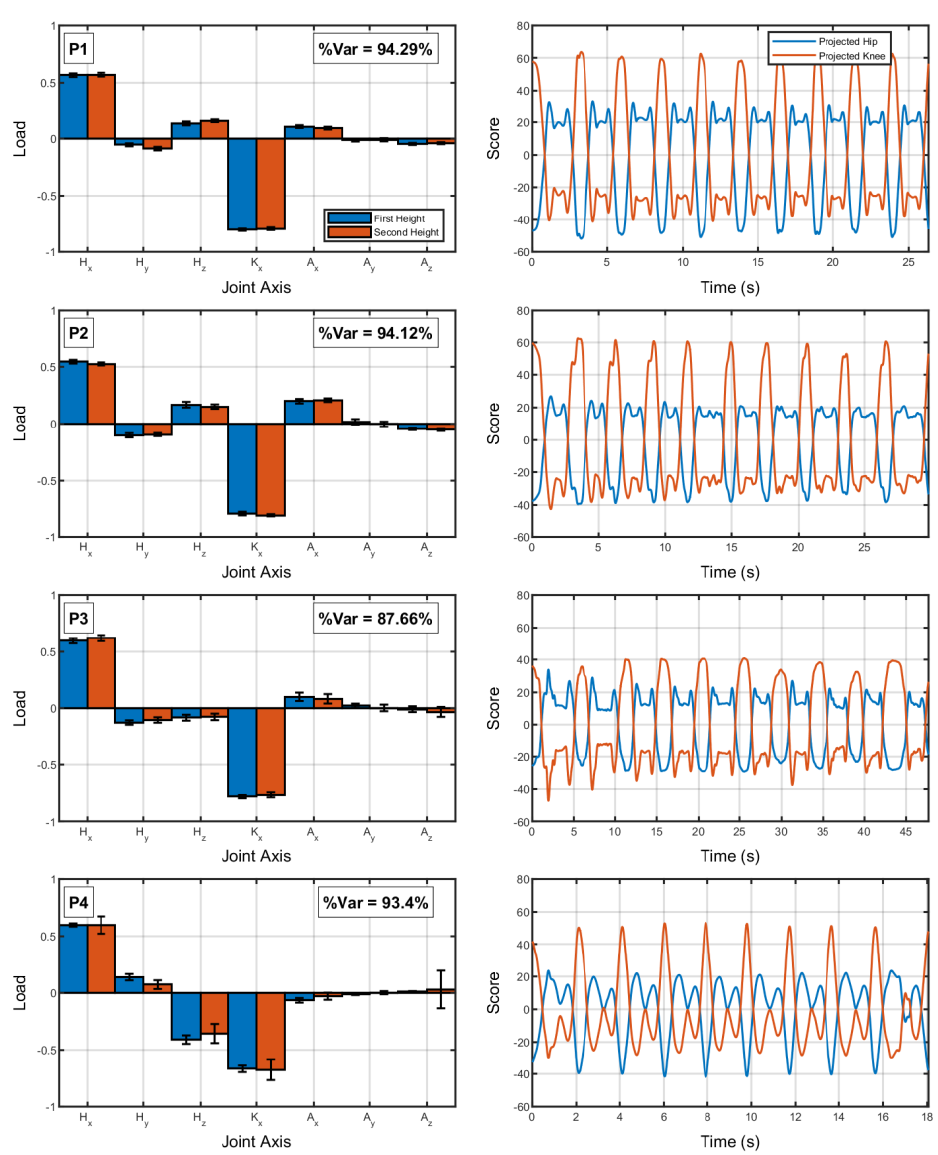
Figure 2. First column: Loadings (and percent variance accounted for) of the first component of the principal component analyses performed on hip, knee, and ankle joints (all seven dimensions). ( P1 – P4 ) refer to each participant. Second column: Projection of hip and knee (flexion-extension) on the first principal component over time.